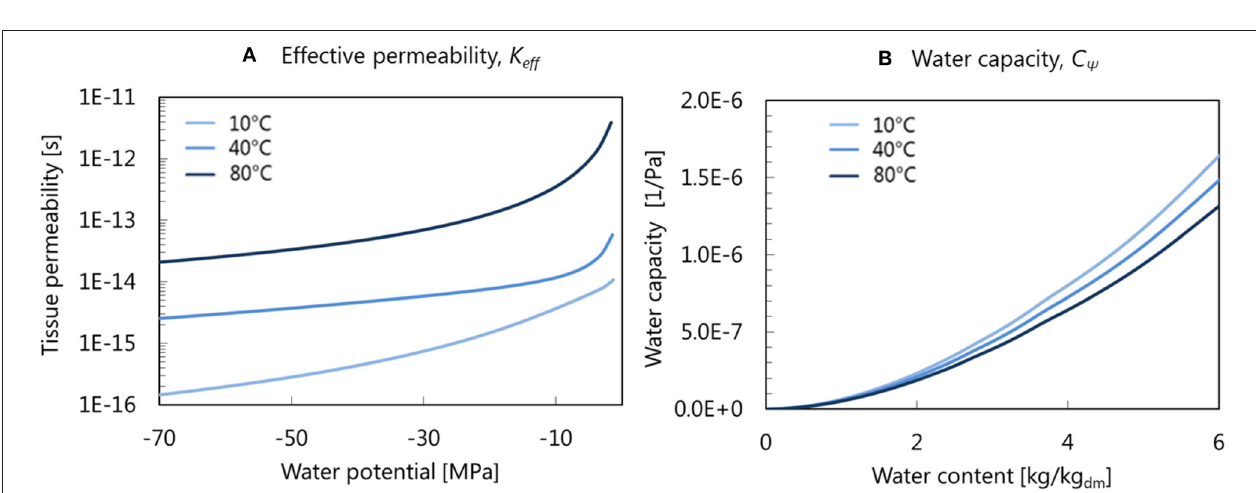
FIGURE 2 | (A) Effective permeability and (B) water capacity used in the drying simulations taking into account the effect of microstructural changes (free shrinkage) on the tissue water transport properties (Prawiranto et al., 2020)—Reproduced by permission of The Royal Society of